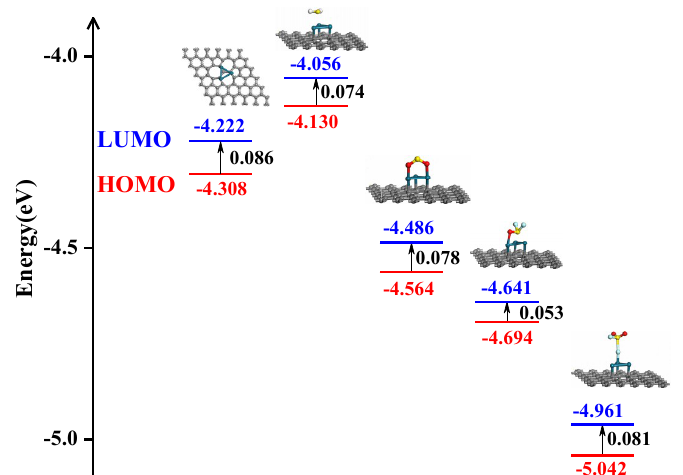
Figure 12. E L , E H and E g of pristine Pd 3 -graphene and various most stable adsorption systems. From the left to the right are pristine Pd 3 -graphene, M1, M4, M7 and M8 systems, respectively.